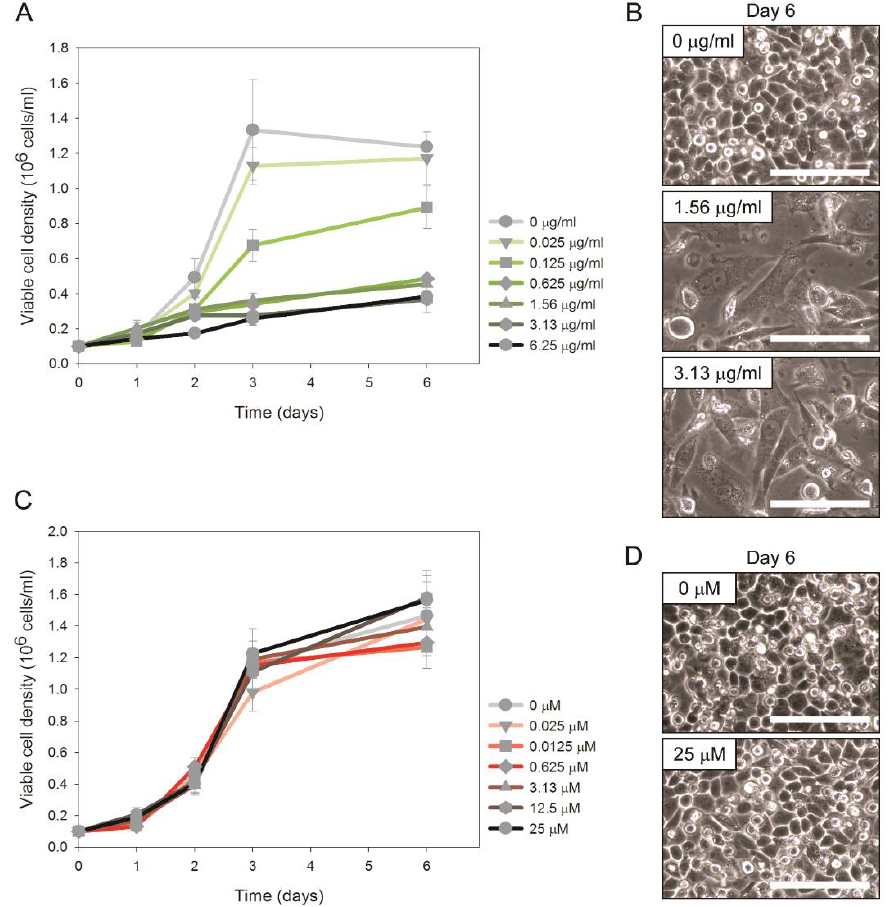
Figure 1. ( A ) Viable cell density and ( B ) phase contrast images of Chinese hamster ovary (CHO)-DUK cells treated with various concentrations of bleomycin. ( C ) Viable cell density and ( D ) cell images of CHO-DUK cells treated with various concentrations of methotrexate (MTX). Error bars represent the standard deviation of biological duplicates. The scale bars are 100 µm.